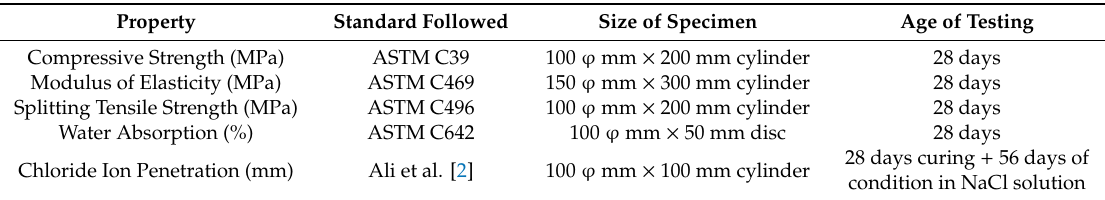
Table 3. Overview of mechanical and permeability testing methods and schedule.